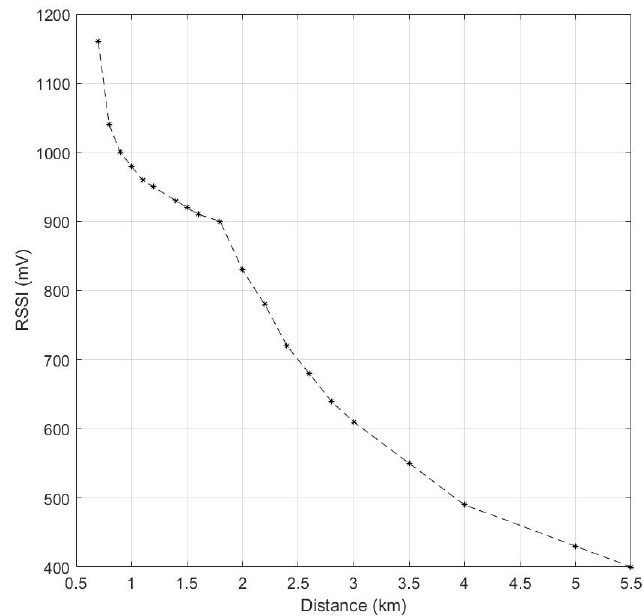
Figure A2. RSSI and Optical power linear Figure A1. RSSI as a function of distance.